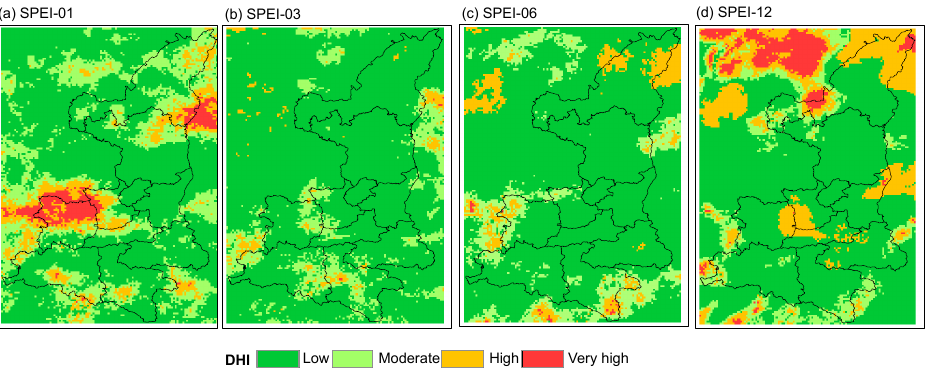
Figure 7. Spatial patterns of drought hazard index for four typical timescales of SPEI, i.e., the SPEI-01 ( a ), SPEI-03( b ), SPEI-06 ( c ), and SPEI-12 ( d ).